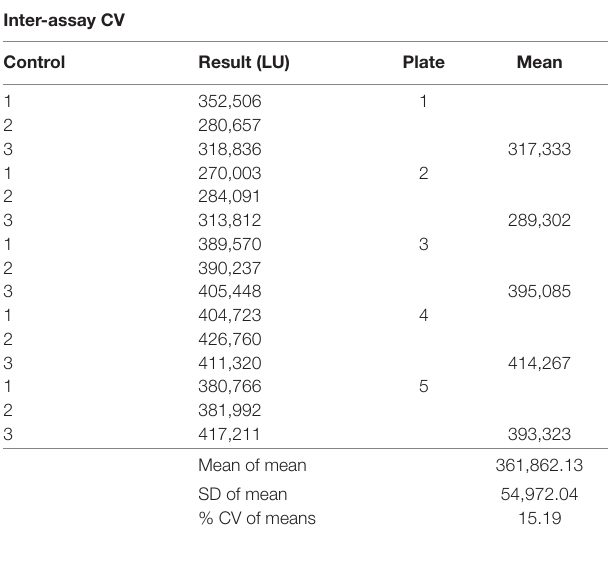
tABLe 2 | Intra-assay coefficient of variability of the tshR-Glo assay. Intra-assay CV